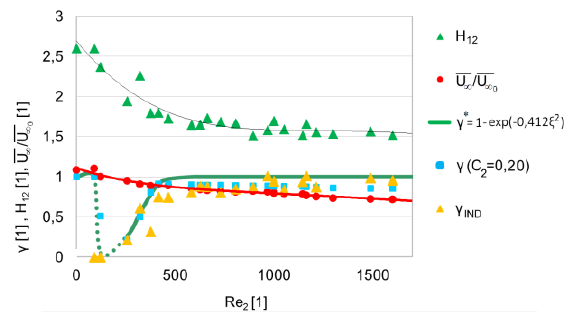
Fig. 10. (Re 2 ), H 12 (Re 2 ), γ (Re 2 ), γ(Re 2 ) IND , / UU  0 γ * (Re 2 ), α = 5°, rough (P32) surface of flat plate,